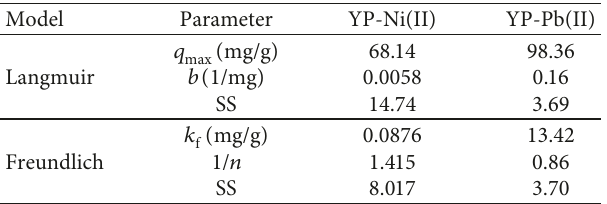
Table 5: Isotherm models for nickel and lead adsorption onto yam peels. Model